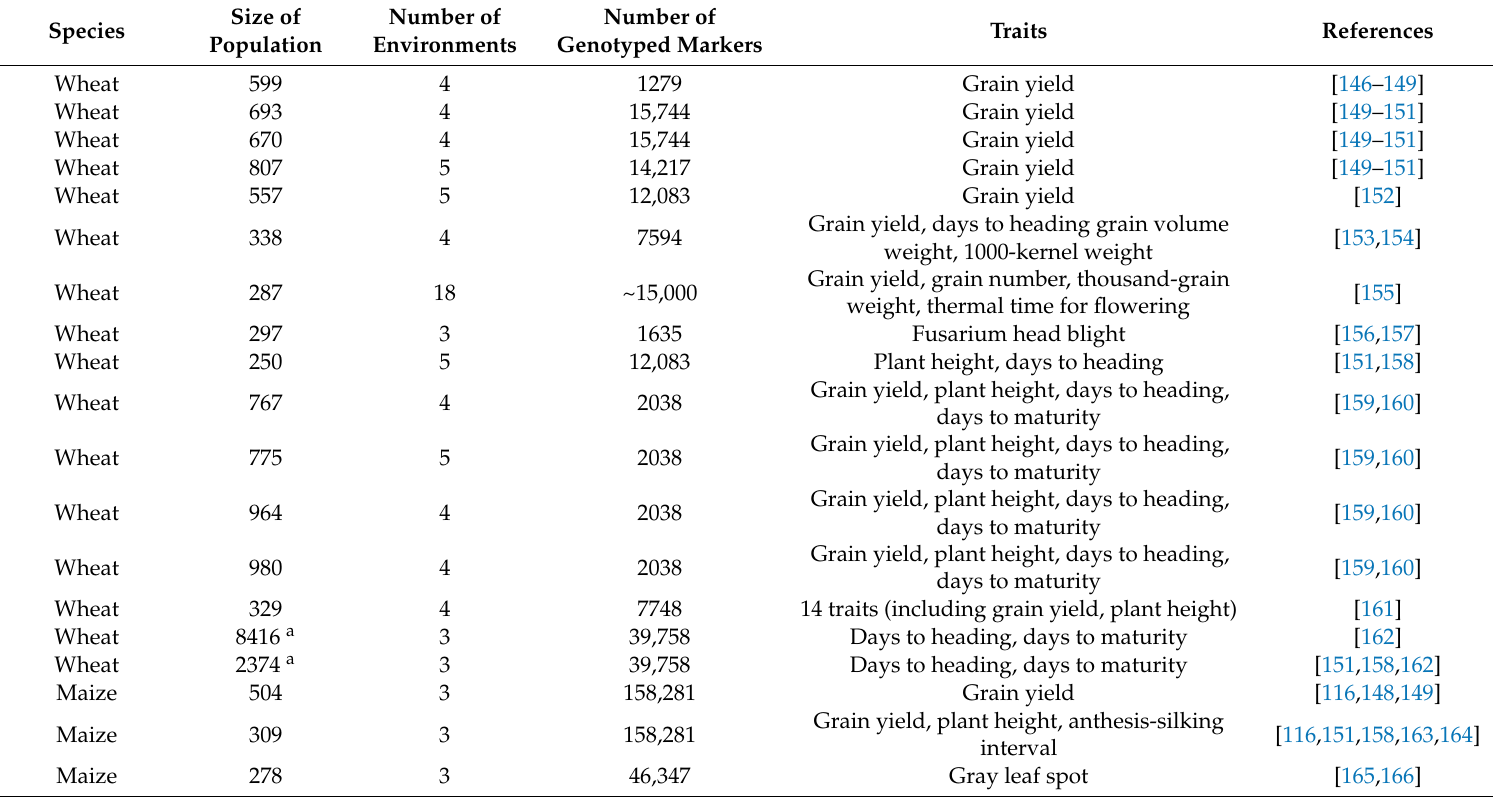
Table 2. Examples of genomic prediction using genotype by environment (G × E) interaction models in wheat and